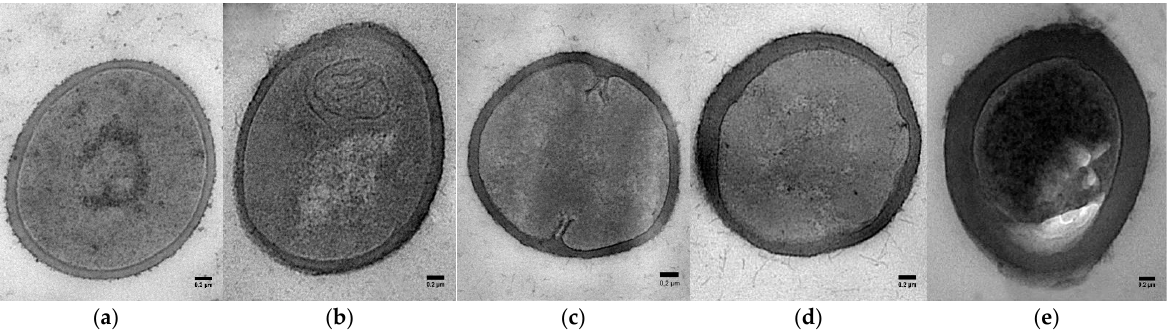
Figure 3. TEM micrographs ( a ) 1-day planktonic (1DP); ( b ) 3-day planktonic (3DP); ( c ) 3-day wet biofilm (3DB); ( d ) 12-day wet biofilm (12DB); ( e ) 12-day dry biofilm (DSB). Scale bar on the images represent 0.2 µm with 46,000× magnification.